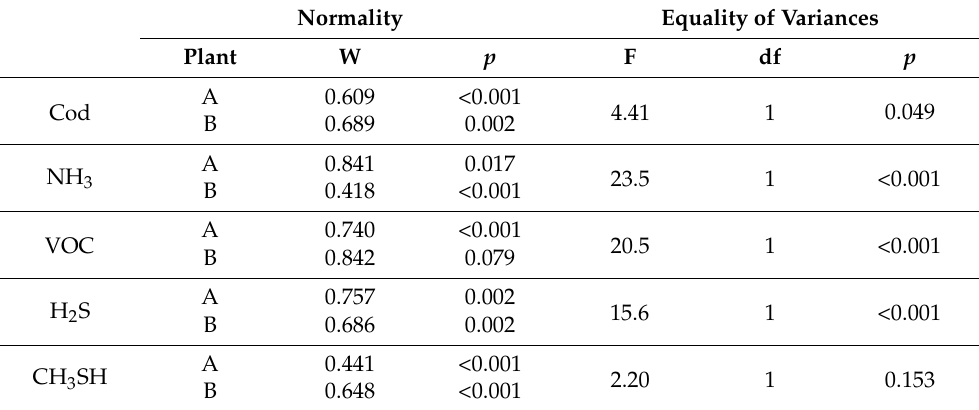
Assumptions checks for independent sample T -test results of air compounds determinations—the test of normality (Shapiro–Wilk test) and test of equality of variances (Lev- ene